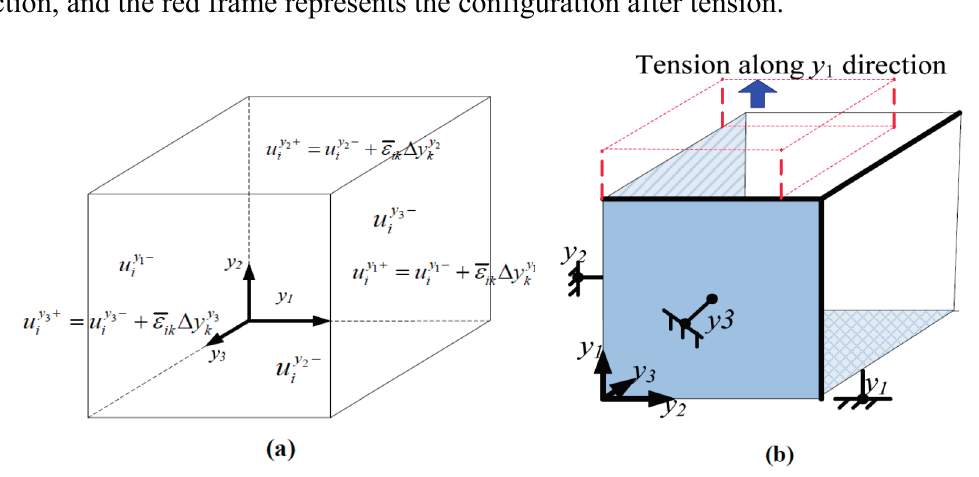
Figure 12. ( a ) An 3D RVE with periodic boundary conditions (PBCs); and ( b ) homogenization boundary conditions (HBCs) ― tensile case along y 1 direction (only the normal directions are fixed at the boundaries). The blue arrow represents the tension direction, and the red frame represents the configuration after